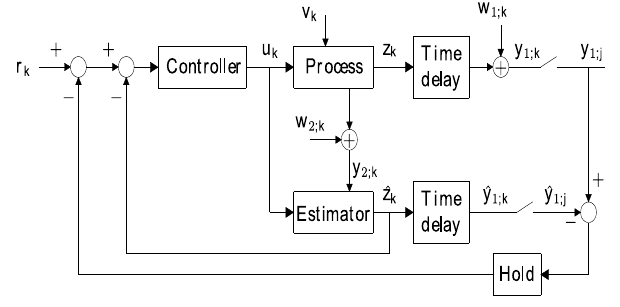
Figure 1: Modified Smith-predictor multirate control utiliz- ing secondary process measurements.